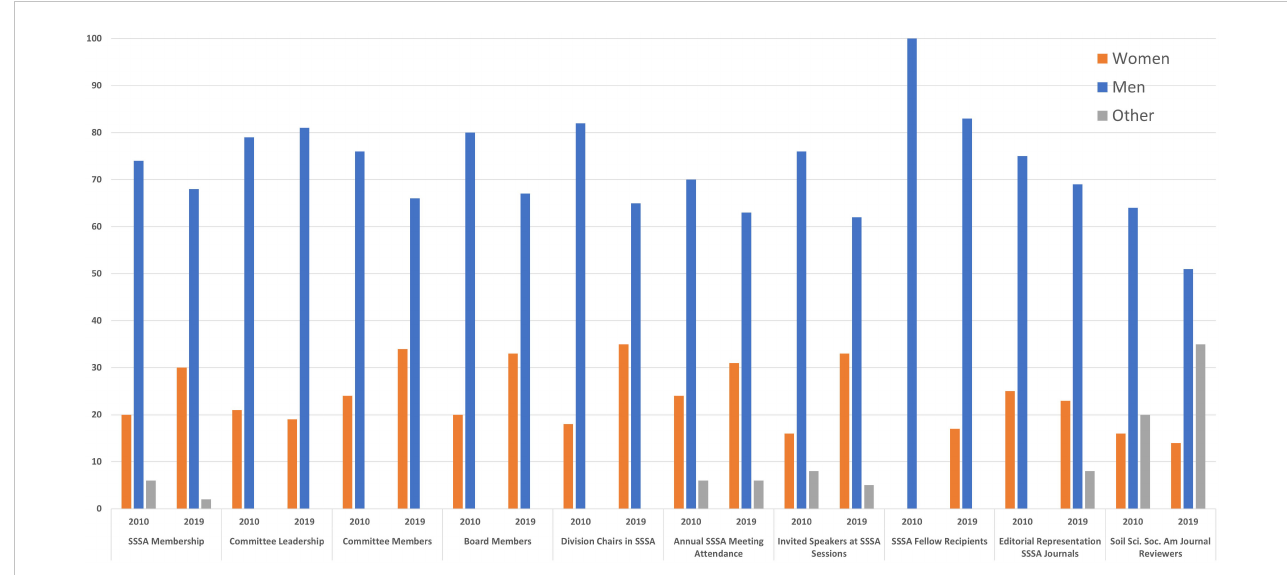
FIGURE 1 Data compiled from the “ Report: Gender and the Soil Science Society of America ” (source: SSSA: Soil Science Society of America. https://www.soils.org/